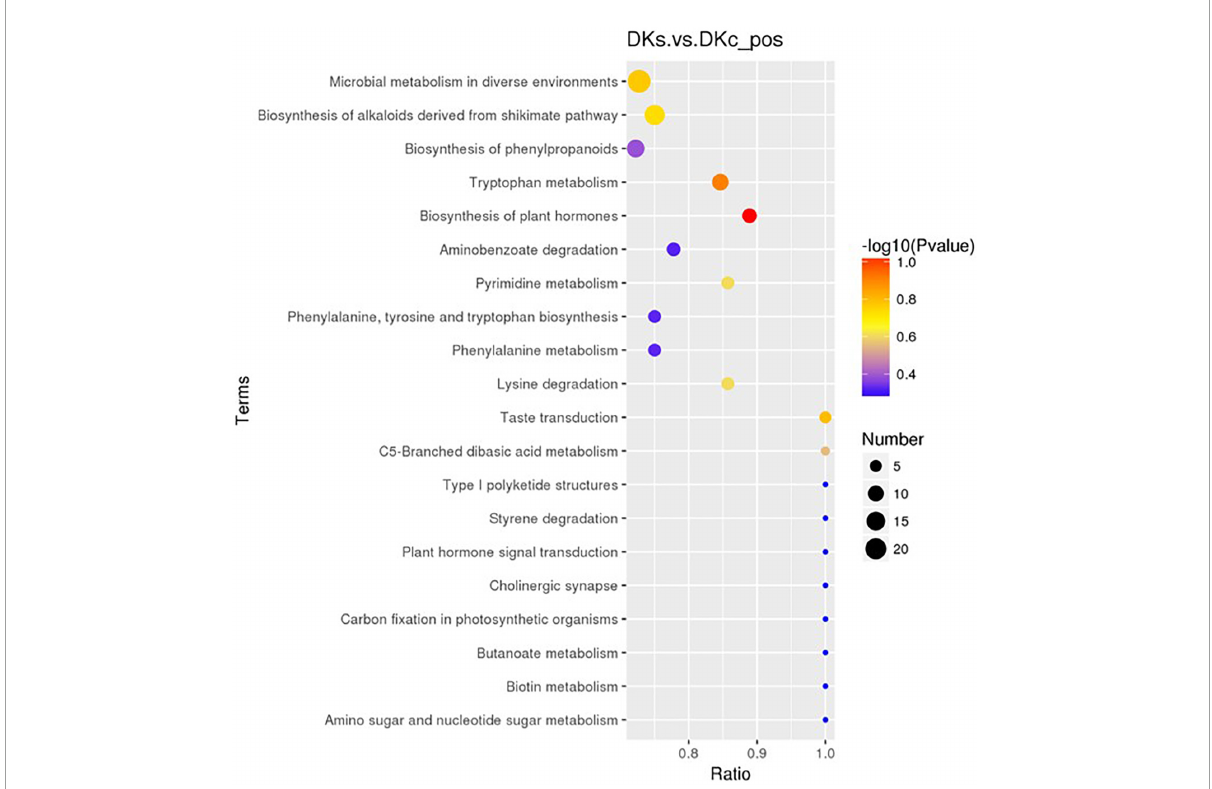
FIGURE6 The Kegg pathway that the significant different metabolites take part in between the DKc group and DKs group. The abscissa is x/y (the number of differential metabolites in the corresponding metabolic pathway/the total number of metabolites identified in the pathway). The larger the value, the higher the enrichment of differential metabolites in the pathway. The color of the dot represents the p-value of the hypergeometric test. The smaller the value, the greater the reliability of the test and the more statistically significant. The size of the dot represents the number of different metabolites in the corresponding pathway. The larger the dot, the more differential metabolites in the pathway.